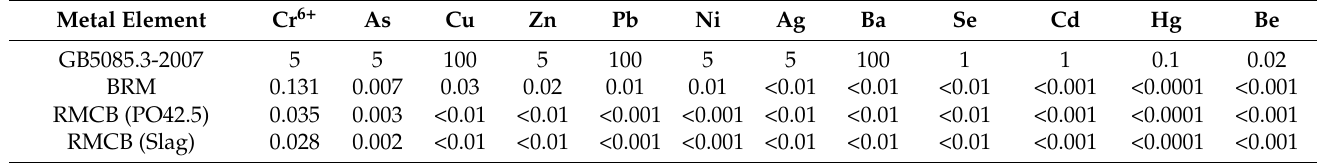
Table 2. Content of heavy metal elements in toxic leaching solution (unit: